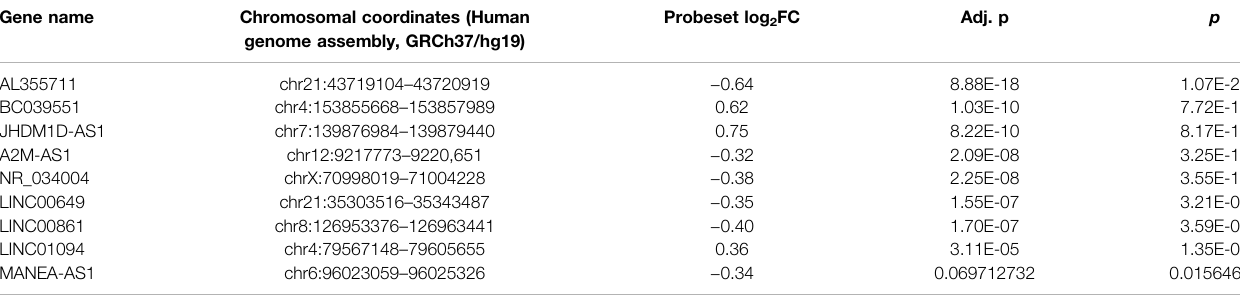
TABLE 1 | Nine differentially expressed long non-coding RNAs (lncRNAs) and long intergenic non-coding RNAs (lincRNAs). p -values and fold changes of time course differentially expressed [TDE] ncRNA transcripts (LincRNAs and antisense lncRNAs) in normal pregnancy. For genes with multiple Affymetrix transcript clusters, only the cluster with the lowest p -value is shown.